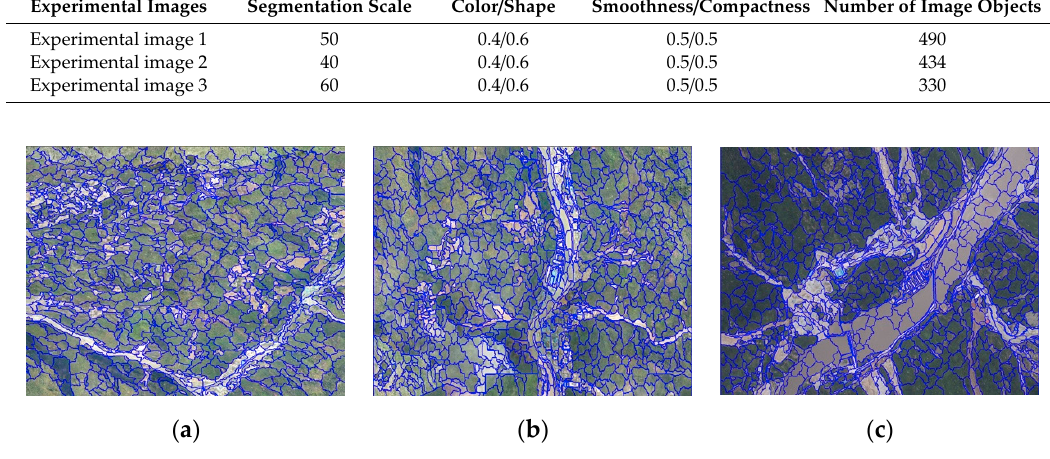
Figure 10. Segmentation results. ( a ) Segmentation result of experimental image 1; ( b ) Segmentation result of experimental image 2; and, ( c ) Segmentation result of experimental image 3.